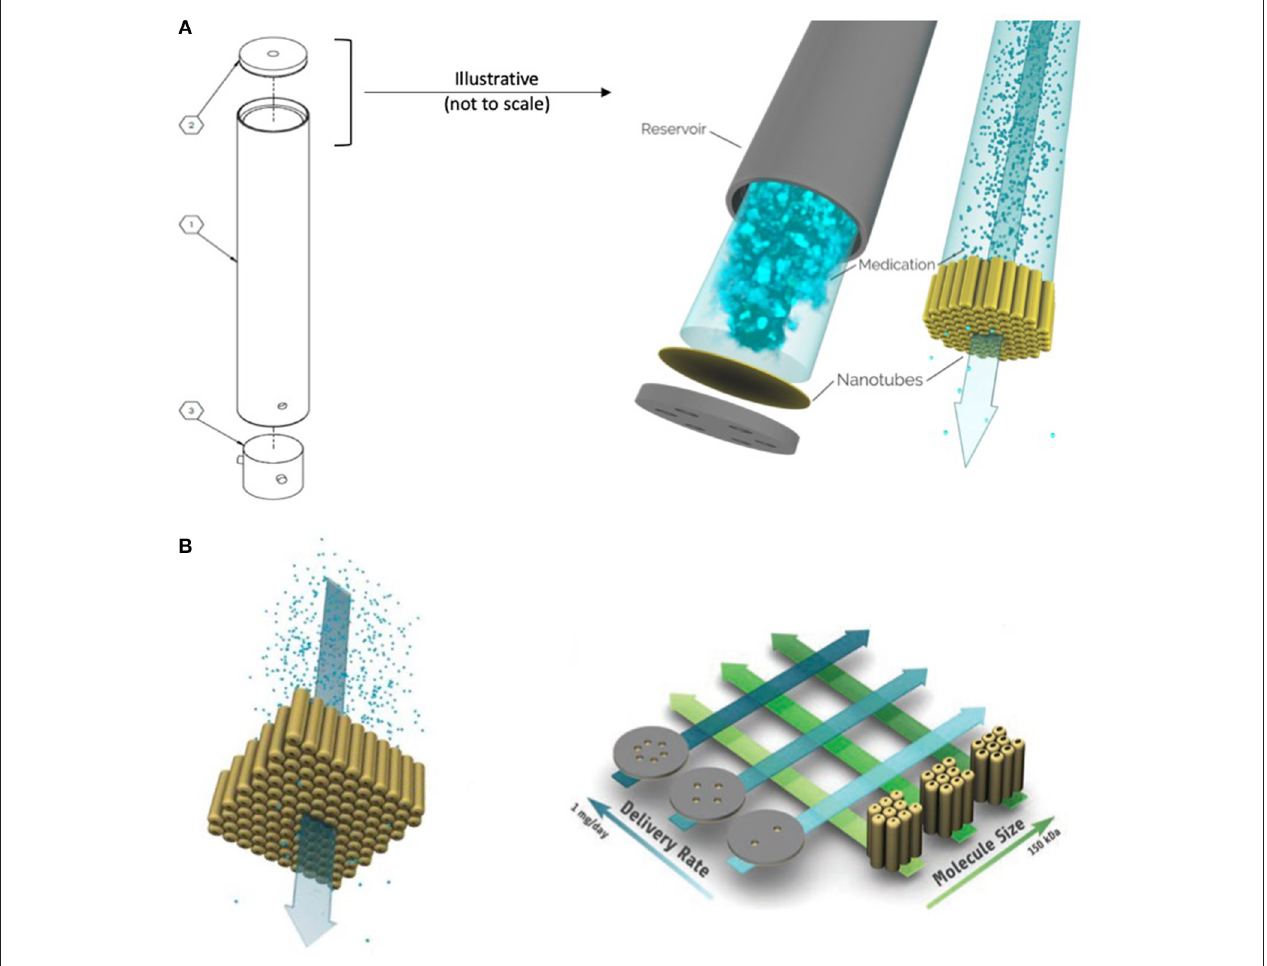
FIGURE 1 | Schematic of the OKV-119 components, titanium reservoir (part 1), NanoPortal membrane (part 2) and silicone septum (part 3) (A) . This drug delivery system measures 2mm by 21.5mm. Exenatide is delivered from solution inside a reservoir at a rate that remains constant until the drug is nearly fully depleted. The rate of drug release is controlled by a nanoporous membrane composed of biocompatible titanium oxide (titania) nanotubes and is fabricated affixed to a biocompatible titanium substrate. Target delivery rates can be achieved by adjusting the number of accessible nanotubes (i.e., the number of windows is correlated to release rate) and the size of the nanopores (i.e., larger pores have faster release rates) (B) . [figures reproduced from Fischer et al. ( 33) and Fischeret al.